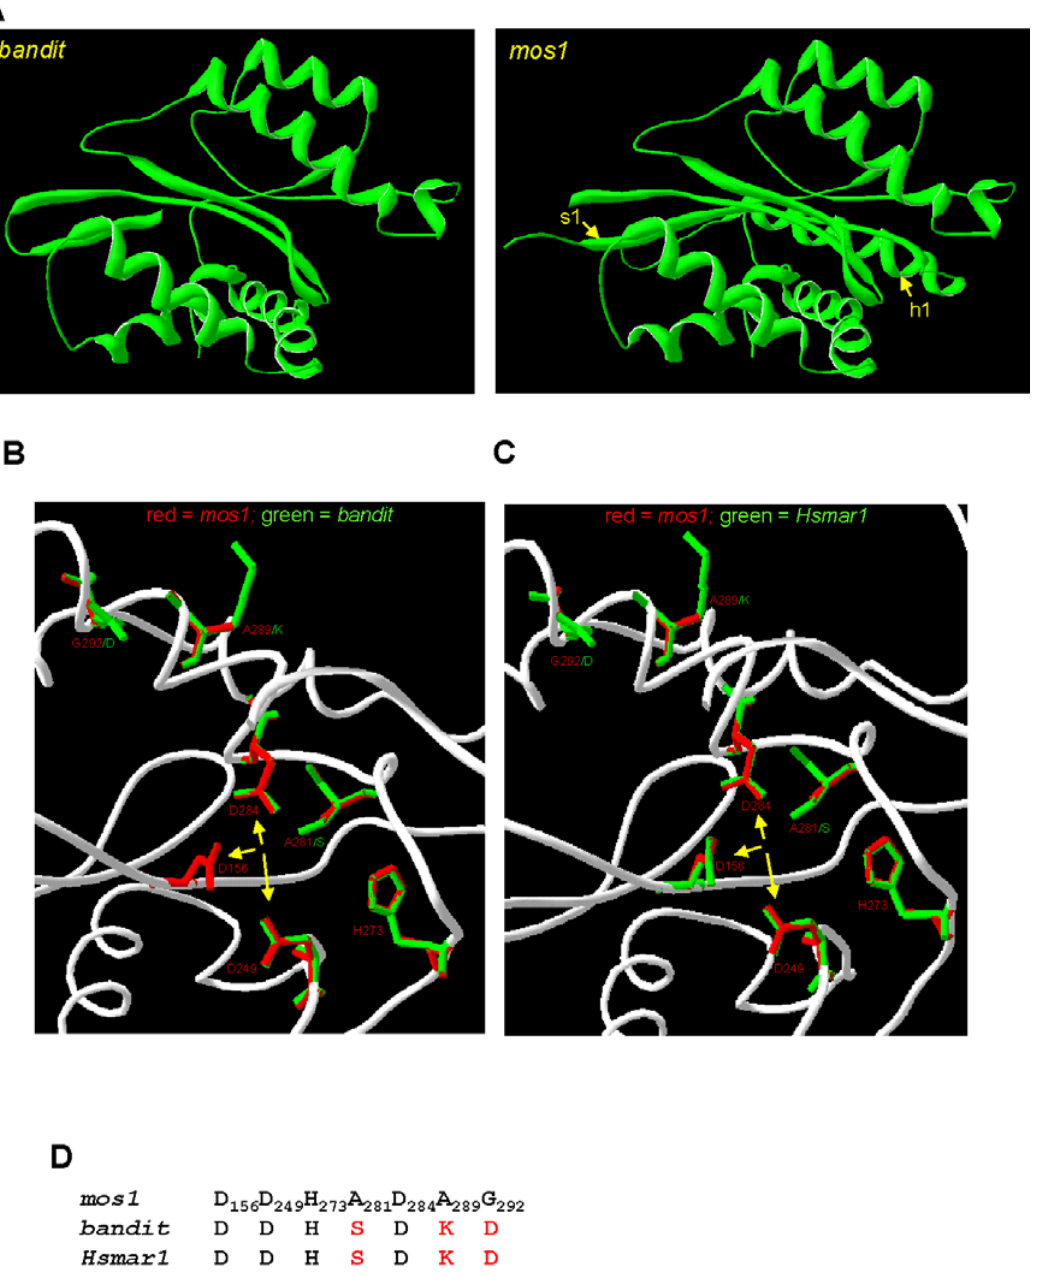
Figure 5. Homology models of bandit from Ancylostomacaninum and Hsmar1 from Homosapiens based on the crystal structure of the mos1 element from Drosophilamauritiana. Ribbon diagram showing the predicted structure of the catalytic domains of bandit and mos1 (A). s1 and h1 refer to b sheet number 1 and a helix number 1 of the mos1 catalytic domain–homologous regions were present in bandit but were not included in the model. Superimposition of the catalytic active sites of bandit (B) and Hsmar1 (C) on the crystal structure of mos1 highlighting the residues involved in catalysis. Conserved active site residues are labeled in red font; where bandit or Hsmar1 active site residues differ from mos1, the substitution is denoted in green font. Yellow arrows denote the three catalytic Asp residues. Numbering of side chains is based on the mos1 sequence. Comparison of the residues predicted to be involved in catalysis from bandit , Hsmar1 and mos1 (D). Residues selected were based on the crystal structure of mos1 .